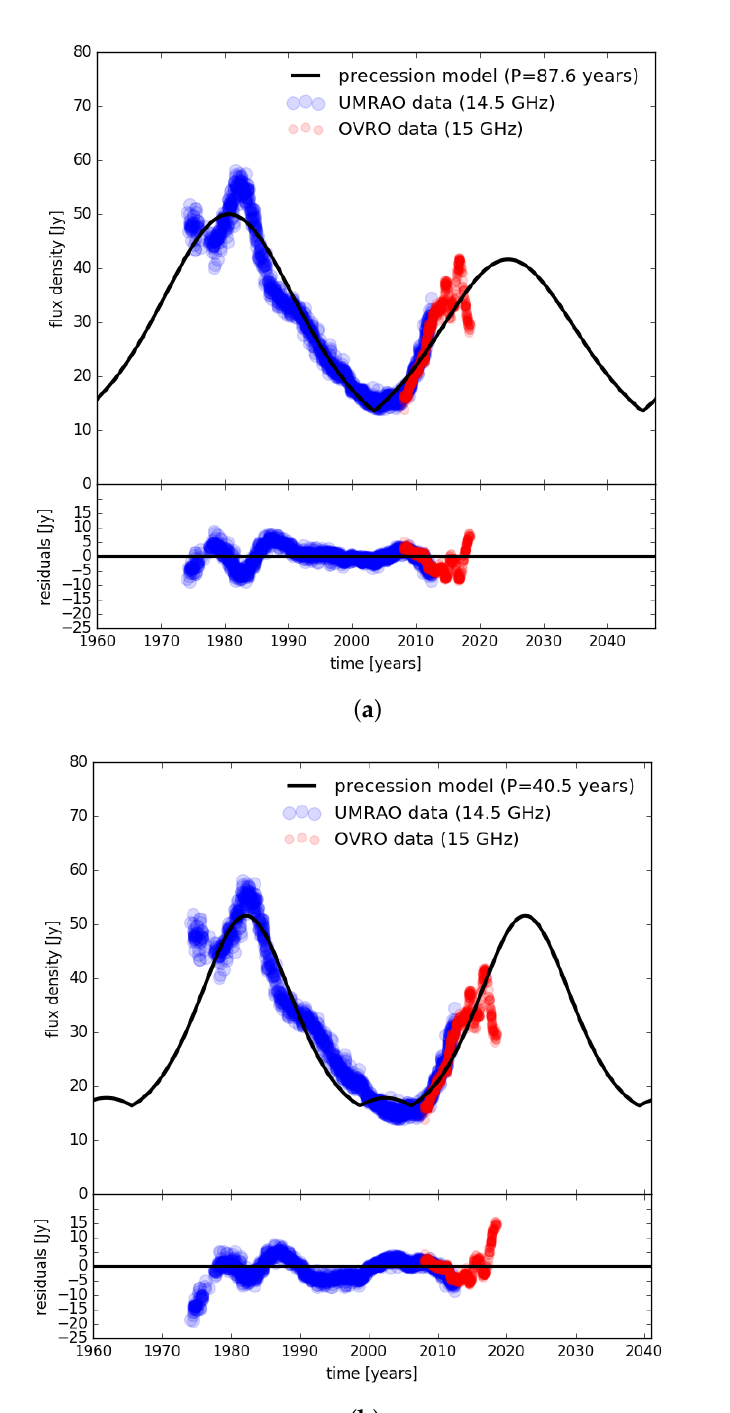
in Table 1: t max = 200 years for the obtained period of 88 years and t max = 50 years for the obtained period of 40.5 years.